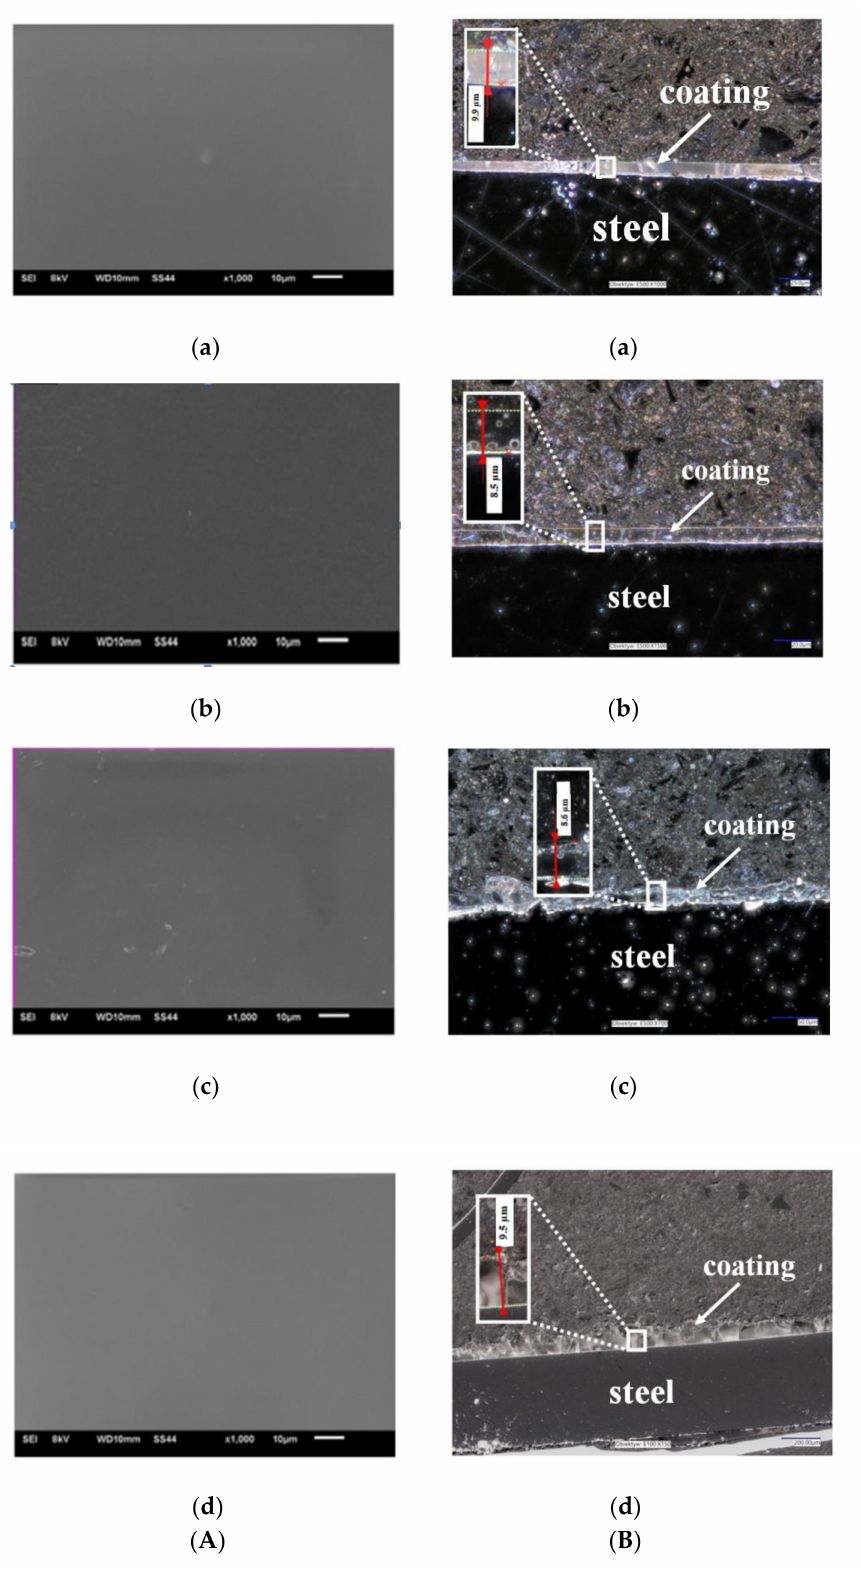
Figure 2. ( A ) Topography of VTMS coatings deposited on steel X20Cr13 (SEM Jeol JSM-6610 LV), ( B ) Cross-section of coatings deposited on steel X20Cr13 (digital microscope KEYANCE VHX 7000, × 200). Coatings: VTMS/EtOH/AcOH ( a ), VTMS/EtOH/LiClO VTMS/EtOH/NH 3 ( d